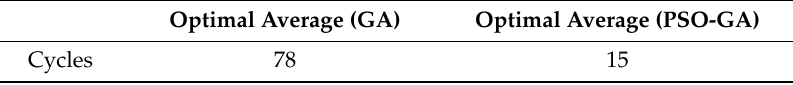
Table 3. Test results of genetic algorithm and hybrid